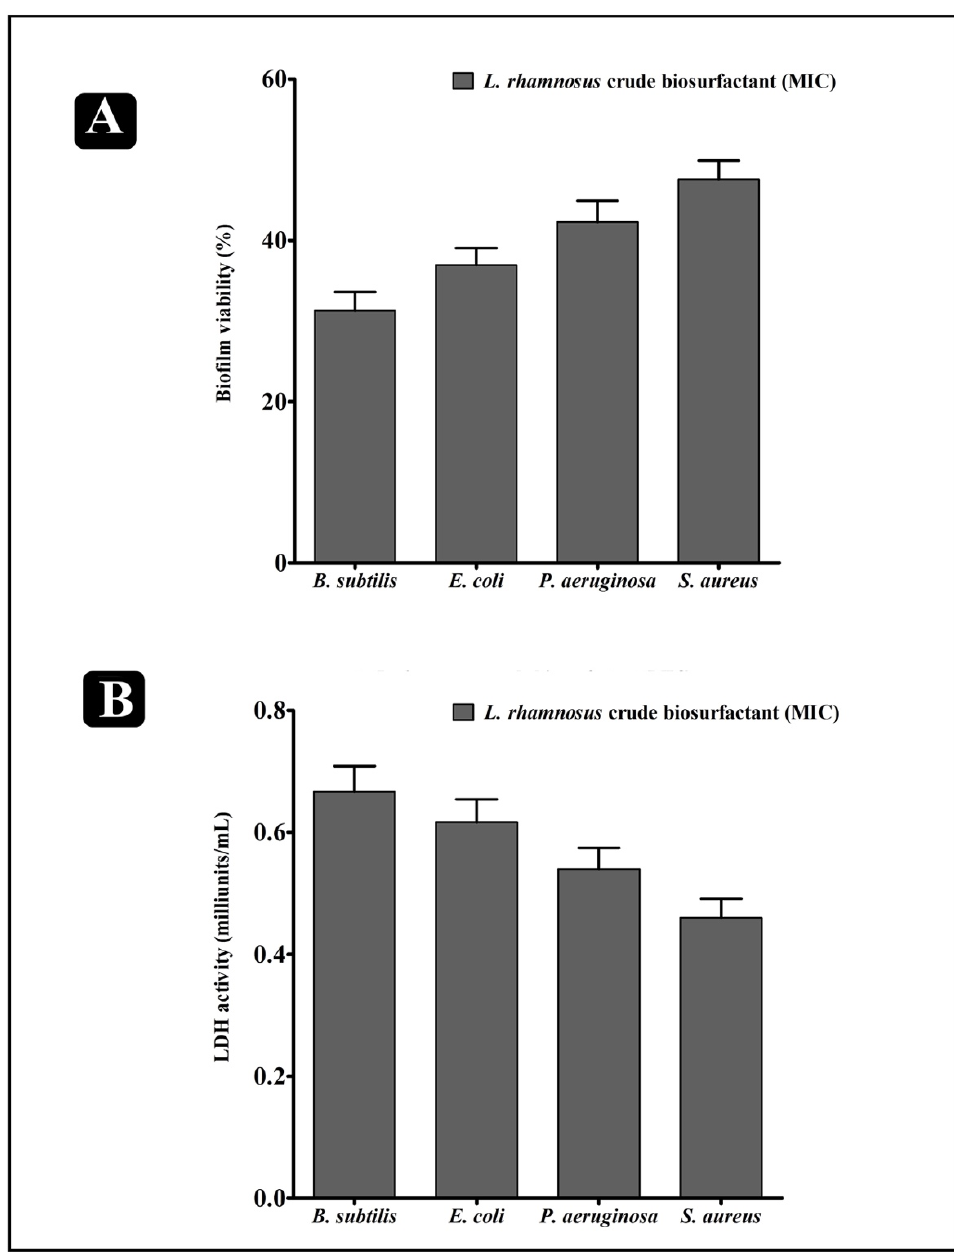
Figure 4. Results of XTT and LDH assays for confirming the antibiofilm potential of the biosurfactant ( A ). Percentage of bacterial viability within biofilms determined by XTT assay at the respective MICs. ( B ) Bacterial cell damage within the biofilm, based on LDH activity upon the treatment of the L. rhamnosus crude biosurfactant at the respective MICs. Values are the mean ± SD of three independent experiments.